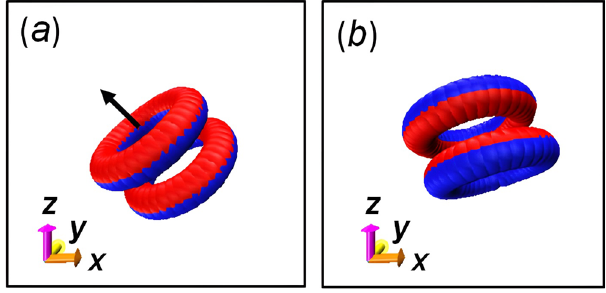
Fig. 6 Bound states of two tori in bulk solution. Instantaneous con fi gurations showing two types of metastable bound state of two tori in bulk solution without a gravitational force: a propagating stacked tori with their catalytic surfaces pointing in the same direction. The black arrow indicates the direction of motion. b Tumbling (randomly rotating) stacked tori with their catalytic surfaces pointing towards each other. The red/blue colours correspond to catalytic/non-catalytic